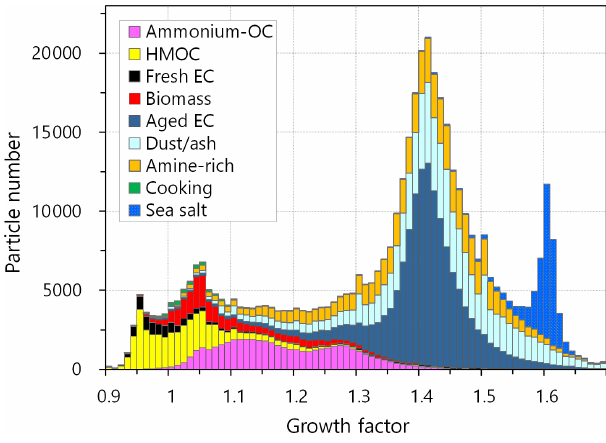
Figure 6. Particle number distribution of different particle types as a function of estimated GF from 12 to 28 September